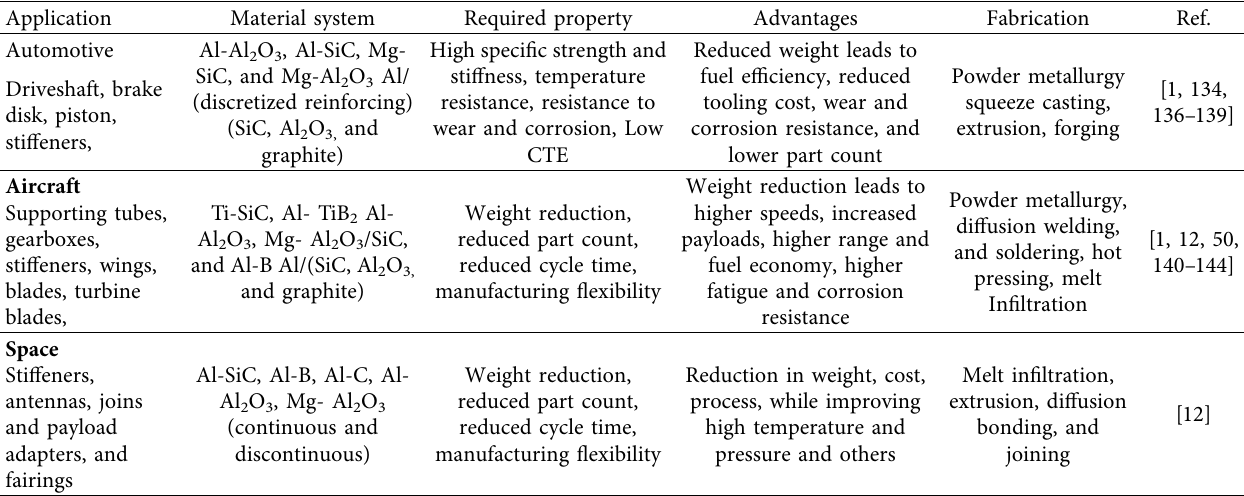
Table 12: Potential applications of AMCs and